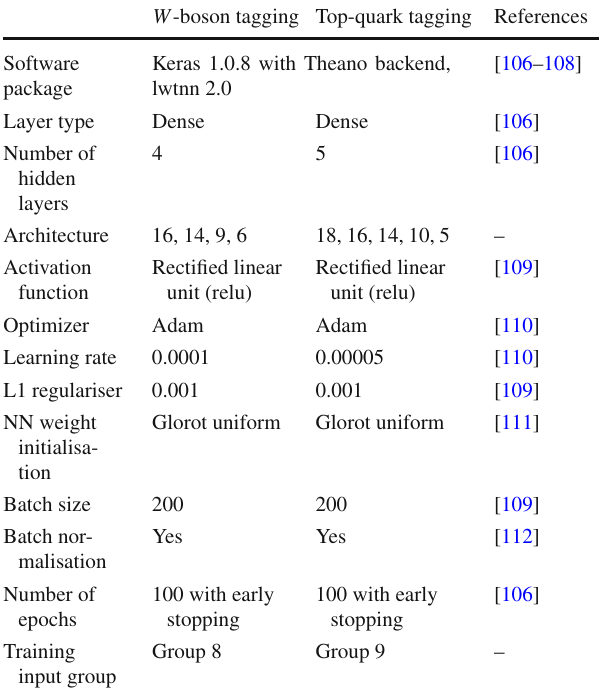
Table 6 Chosen DNN parameters and architecture for shape-based W - boson and top-quark